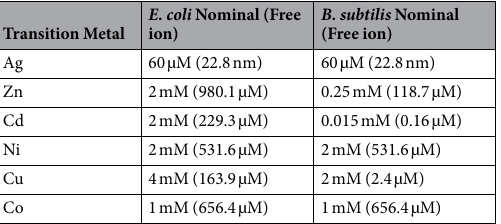
Table 1. Nominal (Free Ion) Minimum Inhibitory Concentrations of Individual Transition Metals. MICs for each of the individual transition metals and Ag were determined under identical culture